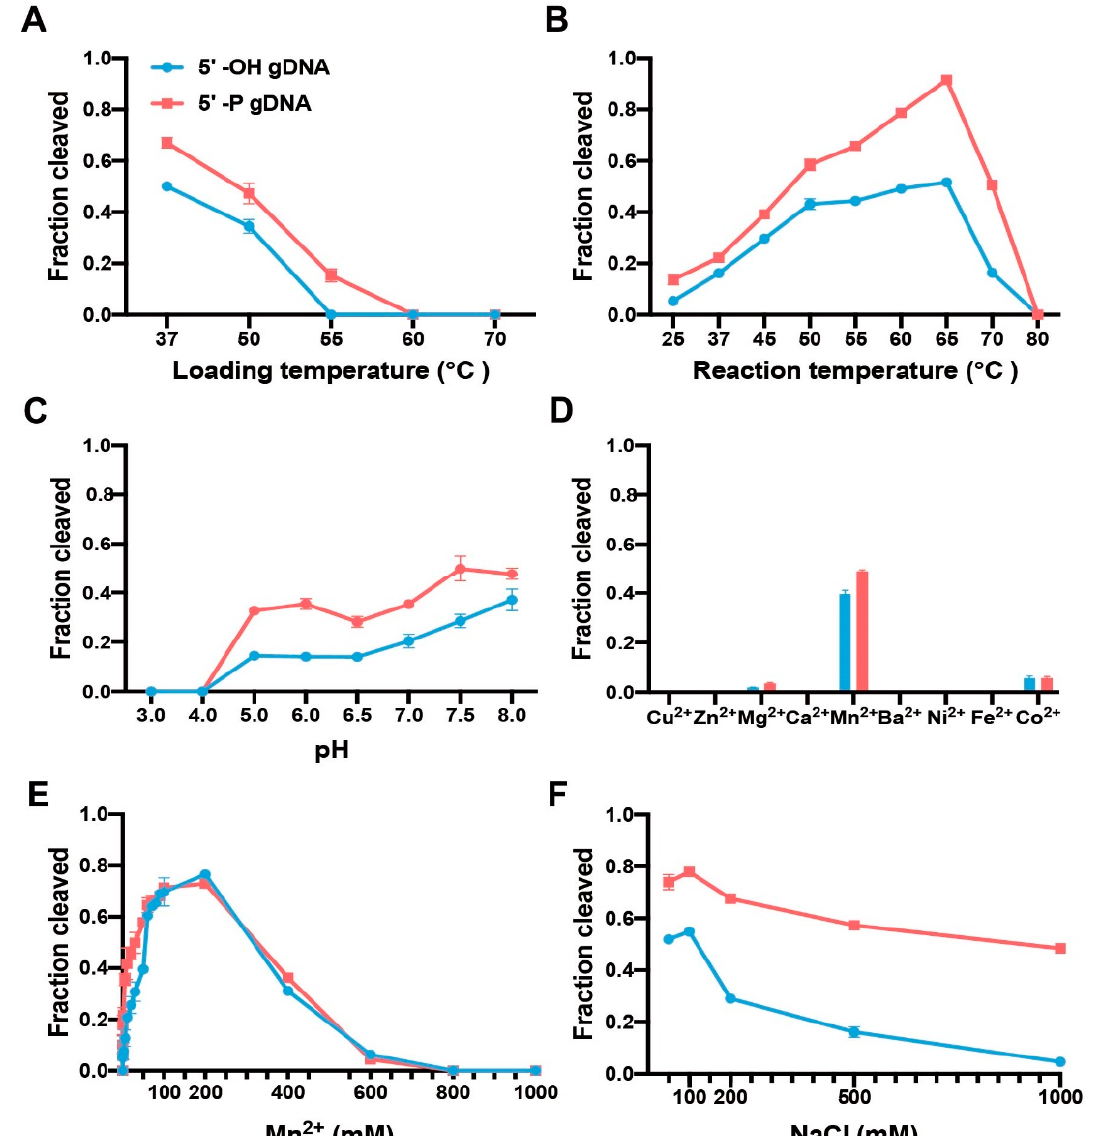
Figure 2. Impact of reaction conditions on CdAgo catalysis. ( A ) The loading temperature impact (guide-CdAgo assembly). ( B ) The reaction temperature impact. The reaction time was 1 h. ( C ) The pH impact. The reaction time was 1 h. ( D ) The divalent cation impact. The cation concentration was 5 mM. ( E ) The Mn 2+ concentration impact. ( F ) The NaCl concentration impact (see also Figure S2). Means and standard deviations from three independent experiments are shown in each panel.